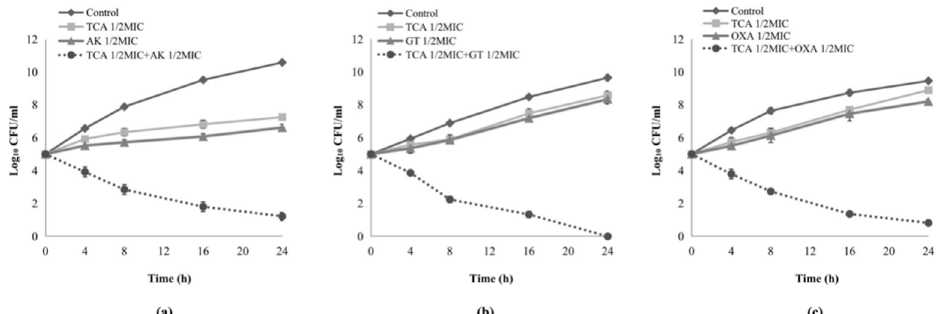
Figure 1. Time–kill curves of the synergistic effect of TCA in combination with three conventional antibiotics at sub- inhibitory concentrations against methicillin-resistant Staphylococcus aureus (MRSA). ( a ) Time–kill curves of combination between TCA and amikacin against reference strain ATCC 33591. ( b ) Time–kill curves of combination between TCA and gentamicin against clinical isolates DPS-1. ( c ) Time–kill curves of combination between TCA and oxacillin against clinical isolates DPS-3. TCA: trans-cinnamaldehyde; AK; CFU, colony-forming units; MIC, minimum inhibitory concentration.